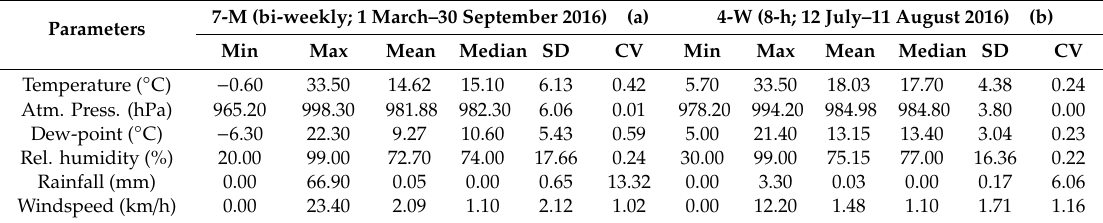
Table 2. Descriptive statistics of meteorological conditions during the (a) 7-months (March–September 2016) and (b) 4-weeks field campaign (12 July–11 August 2016); SD = Standard deviation, CV = Coe ffi cient of Variation.